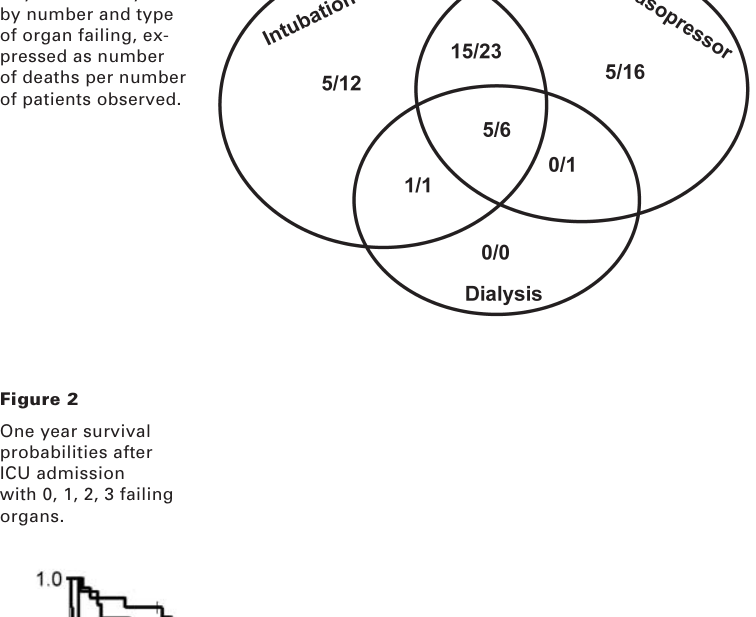
Day 60 mortality by number and type of organ failing, ex- pressed as number of deaths per number of patients observed.